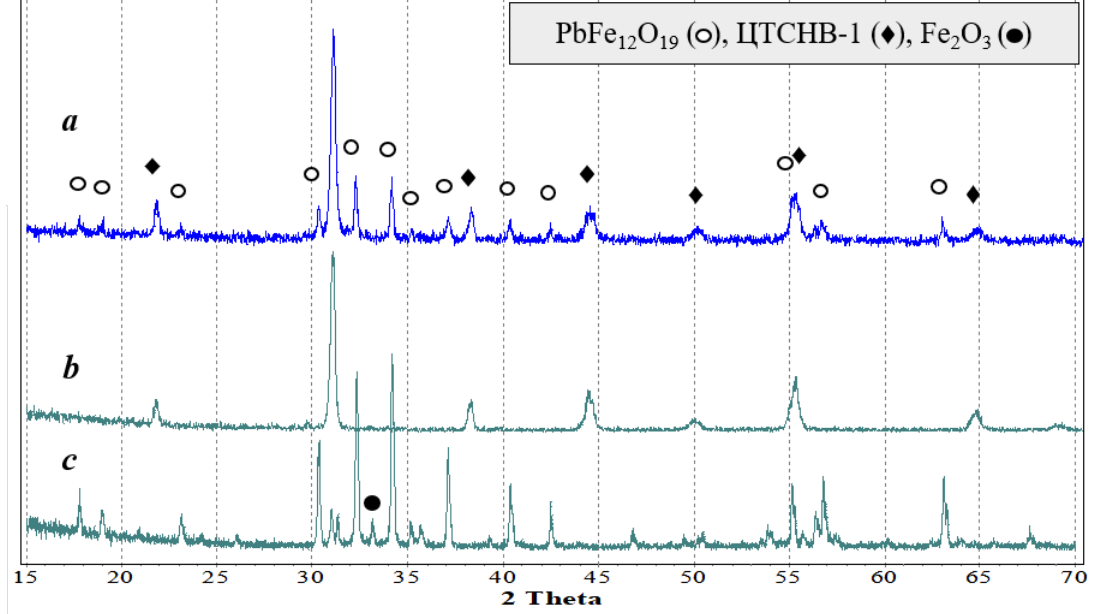
Figure 7. Powder X-ray diffraction patterns ( a ) of composite ceramics 50 wt.% PZTNB-1 + 50 wt.% Pb 1− x La x Fe 12− x Zn x O 19 ( x = 0.1) and the pure phases: ( b ) PZTNB-1 and ( c ) Pb 0.9 La 0.1 Fe 11.9 Zn 0.1 O 19 .